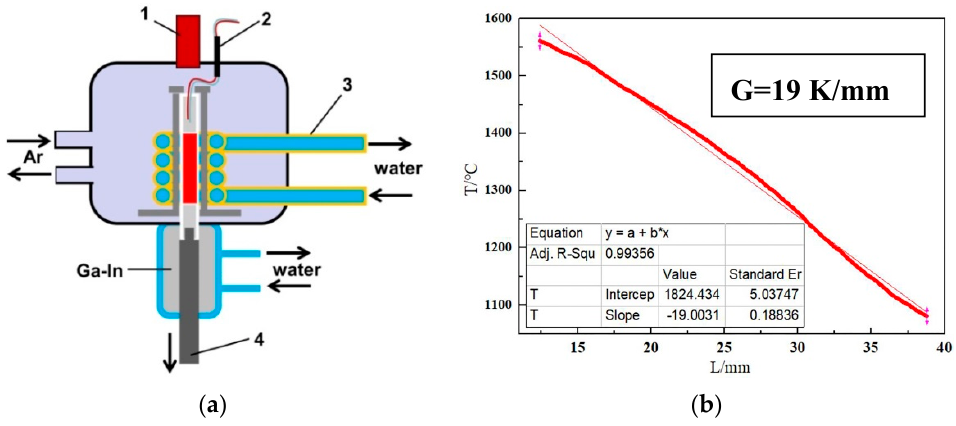
Figure 1. ( a ) Structure of the directional solidification system (1 infrared temperature probe; 2 temperature thermocouple; 3 cooling water and 4 pulling system); ( b ) Temperature gradient test curve.